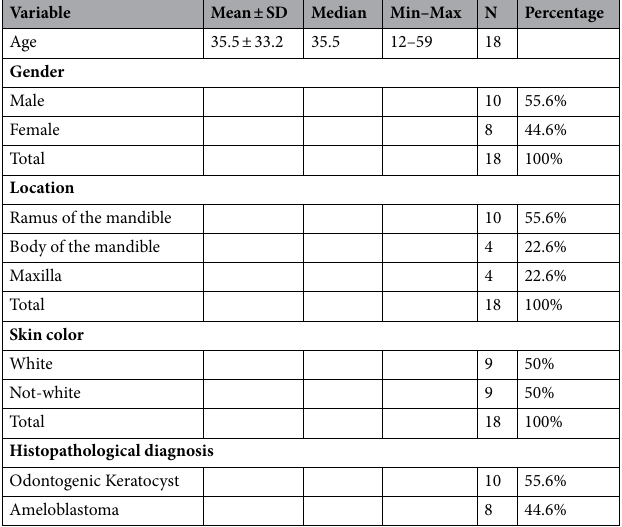
Table 2. Clinical aspects of patients and main features of the odontogenic keratocyst and ameloblastoma. SD, Standard deviation; N, Sample size.